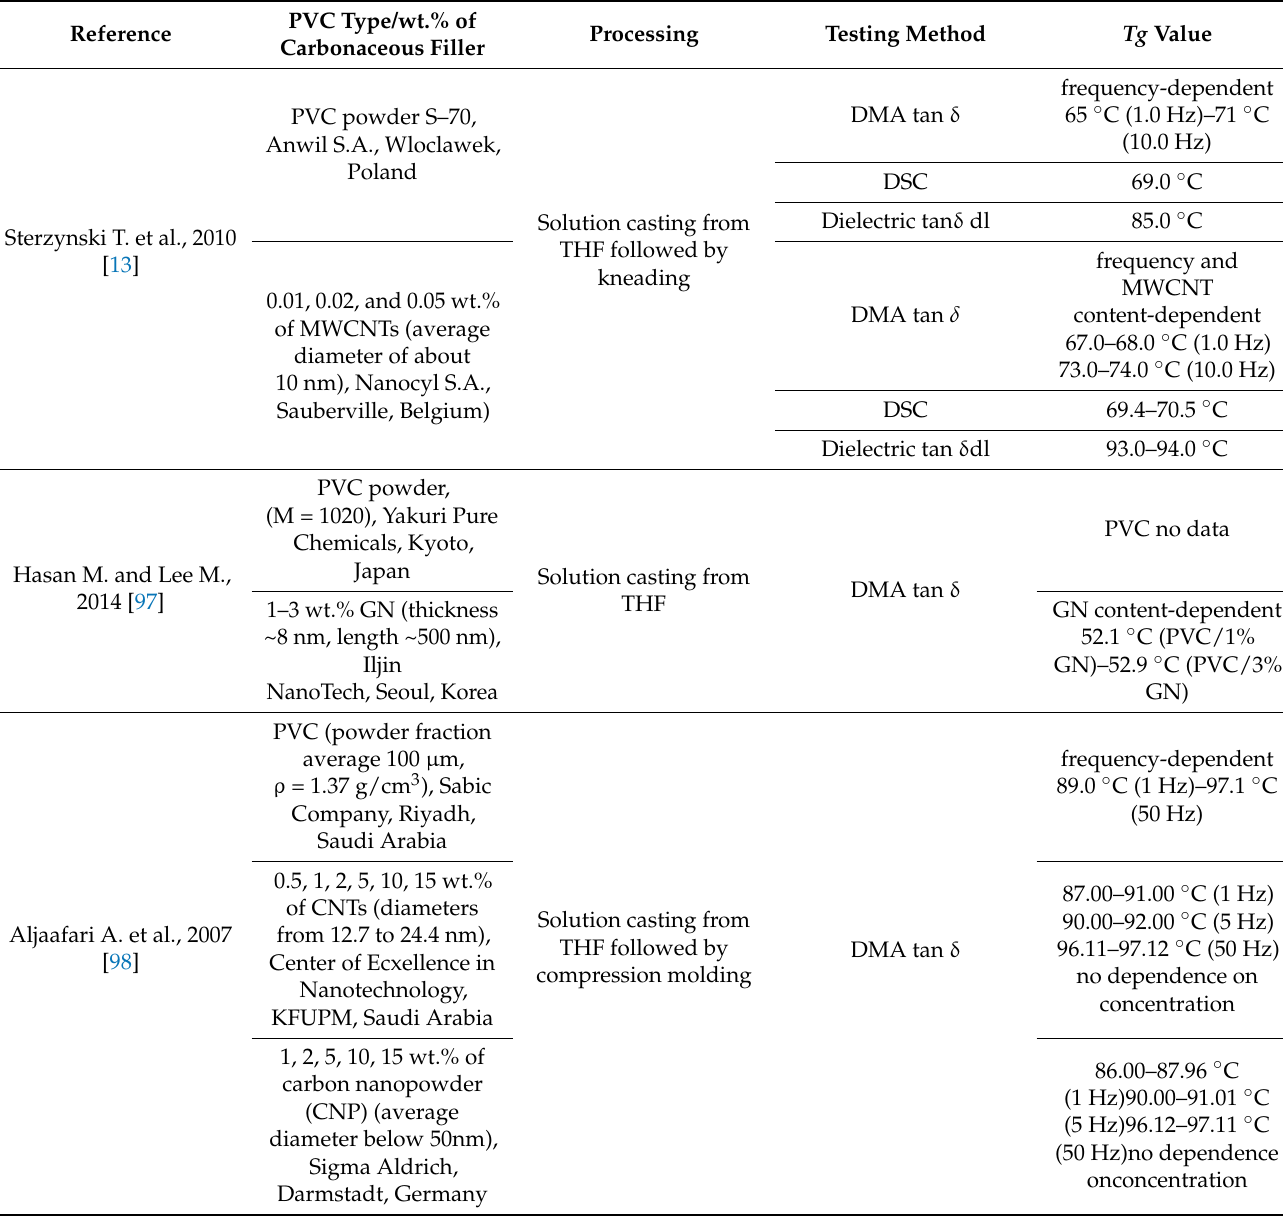
Table 1. Summary of the reported changes in Tg of PVC with carbonaceous nanofillers.